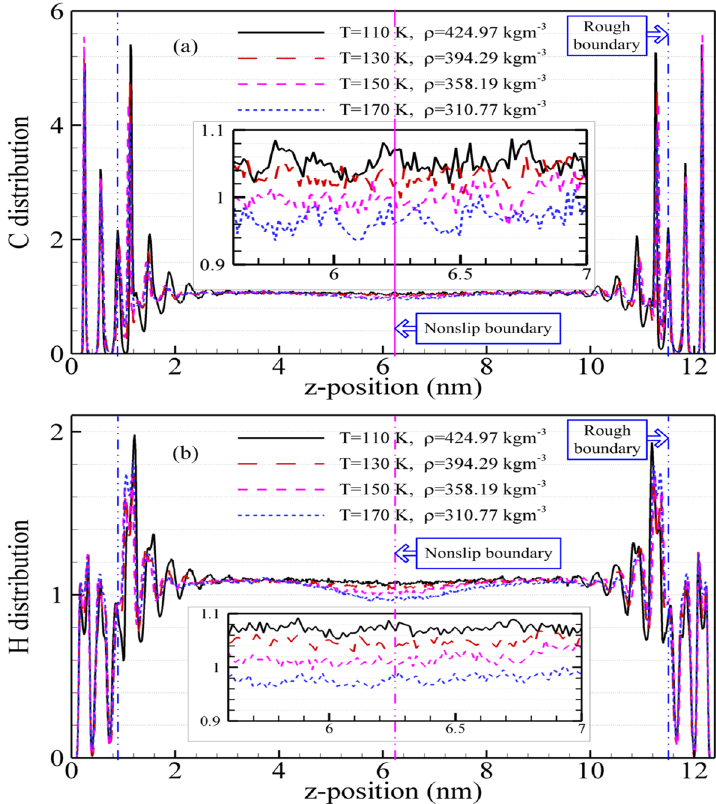
Figure 3. The atoms number density distribution (C ( a ) and H ( b )) from mixture boundary Poiseuille flow model with different state